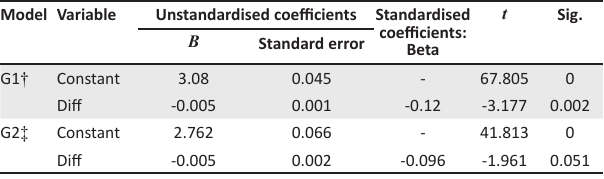
TABLE 7: Conditional regression result of creative talents (corporation